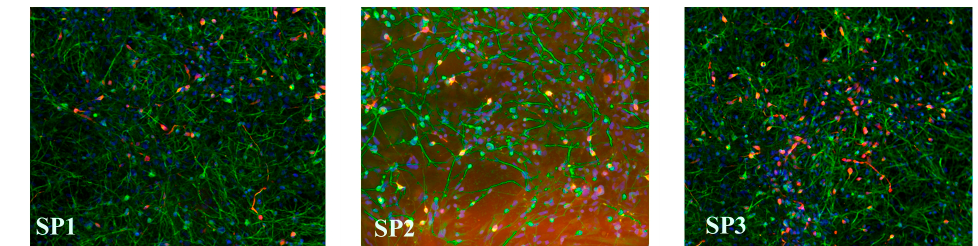
Figure 7. Immunocytochemical staining of DNs obtained by the cultivation of NPC on CCs and MG with antibodies against tyrosine hydroxylase (TH) and the common neuronal marker NeuN. Indi- vidual repeat values in the histogram are indicated by black dots. Mean ± SEM, N = 6. One-way ANOVA followed by Dunnett’s post hoc test. ** p ≤ 0.01 compared with MG. Figure 8. Cont